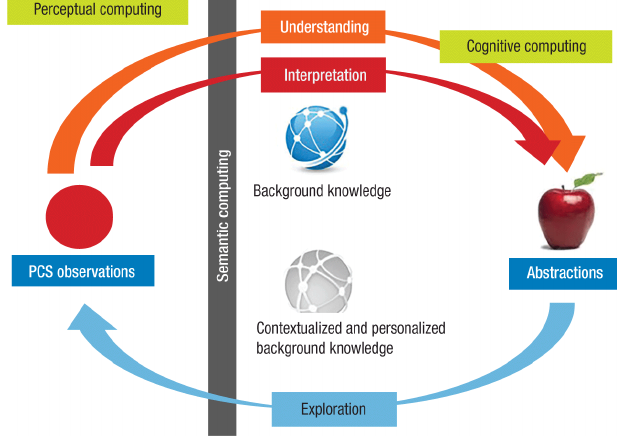
Figure 3. Cognitive, Semantic and Perceptual computing process cycle